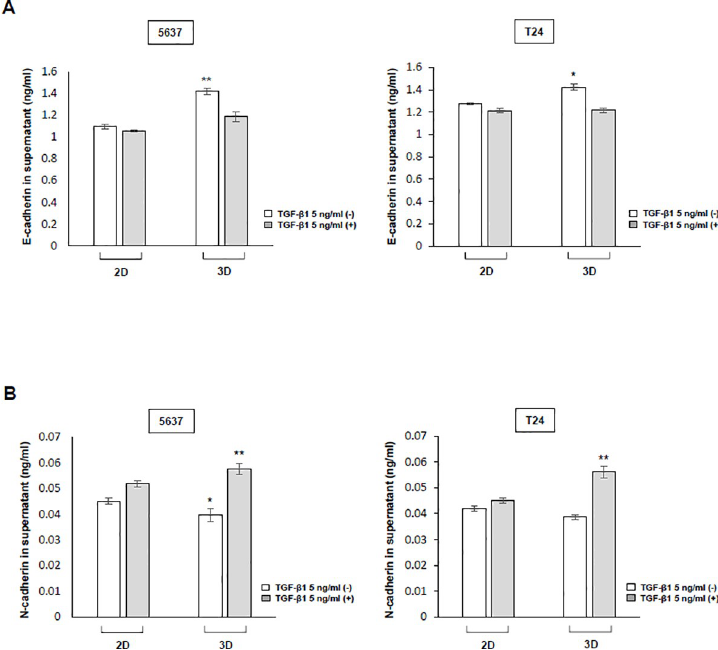
Fig 5. Cell-to-cell marker protein expression in the 2D and 3D cell culture environment. (A), (B) Induction of release of the epithelial-mesenchymal transition (EMT) mechanism protein in bladder cancer cells treated with TGF- β 1. After 72 h, the supernatant of the 5637 and T24 bladder cancer cell culture media was separated, and e-cadherin and n-cadherin were measured by sandwich ELISA. � p < 0 . 05 , �� p < 0 . 01 , ratios were compared between the 2D- and 3D-cultured TGF- β 1-untreated group and the 2D- and 3D-cultured TGF- β 1-treated group. Data are the mean ± SEM of three independent experiments.